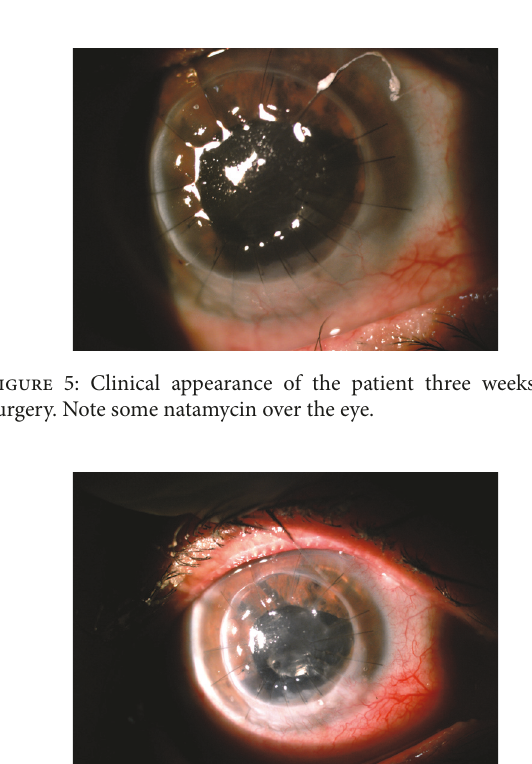
Figure 4: Schematic representation of the areas of the eye covered by the penetrating keratoplasty procedure (blue circle, 8mm) and the noncentered PACK-CXL (green circle, 7 mm).